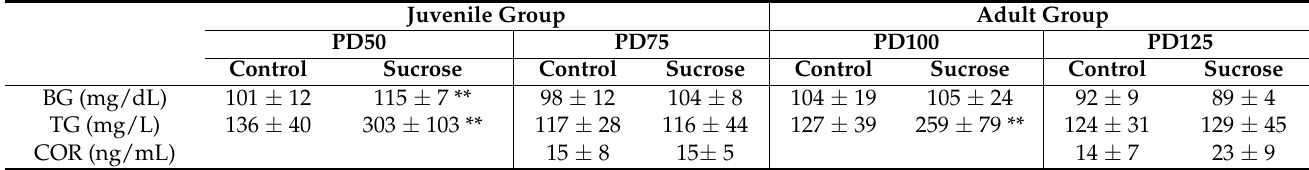
Table 1. Plasmatic levels of BG, TG, and corticosterone (COR) at the end of the 25 days of sucrose treatment and 25 days after finishing the sucrose treatment. Data are presented as mean ± SD from two independent experiments, n = 8–10 (ND: undetermined). Tukey’s post hoc test showed differences by sucrose treatment, ** p < 0.005.